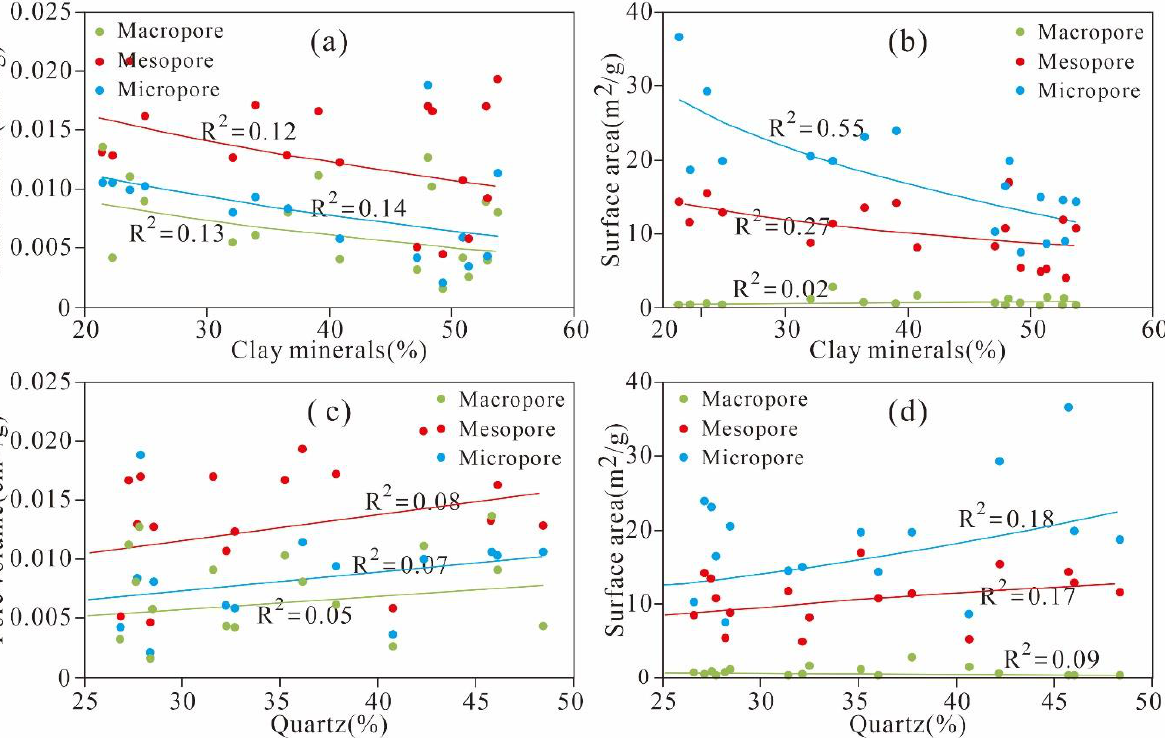
Figure 11. PVs and SAs of different scales versus the clay mineral content ( a , b ) and quartz content ( c , d ).